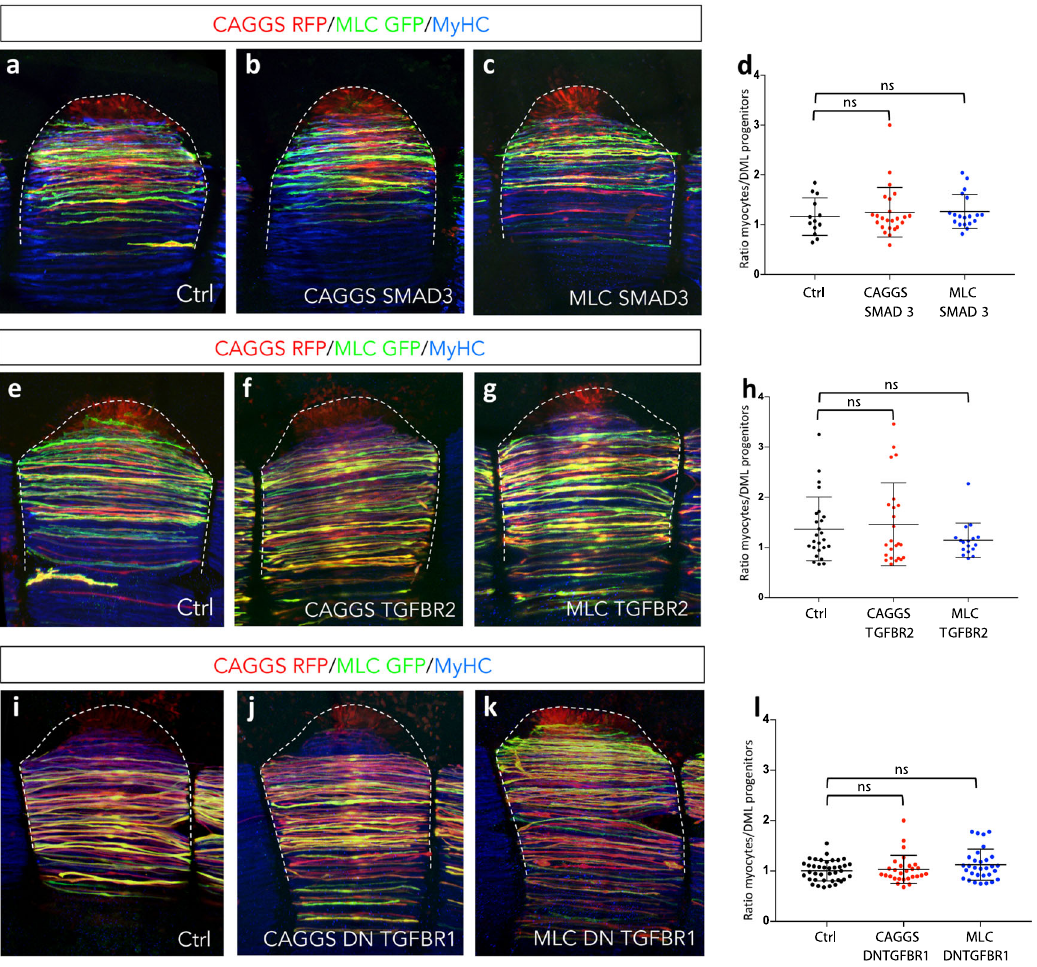
Fig. 2 SMAD2/3-dependent TGF β signalling does not regulate myogenic differentiation in vivo. a – c , e – g , i – k Dorsal views of confocal stacks of somites observed at E4.5. To test myogenic differentiation, they were electroporated in the DML at E2.5 with the ubiquitous (CAGGS) promoter ( b , f , j ) or the muscle speci fi c MLC promoter ( c , g , k ) driving expression of SMAD3 ( b , c ), TGFBR2 ( f , g ) and DN TGFBR1 ( j , k ). (CAGGS empty vector as control). They were also co-electroporated with two plasmids, CAGGS RFP (red) and MLC GFP (green) that label all electroporated cells or only myocytes, respectively; in blue, MyHC staining. d , h , l Scatter plots graphs showing the ratio of myocytes generated from the electroporated DML progenitors in each conditions. Statistical analyses: CAGGS SMAD3: (cid:1) x : 1.25; n = 24; CAGGS SMAD3 vs Ctrl, Mann – Whitney non-parametric test: P -value: 0.71; MLC SMAD3: (cid:1) x : 1.27; n